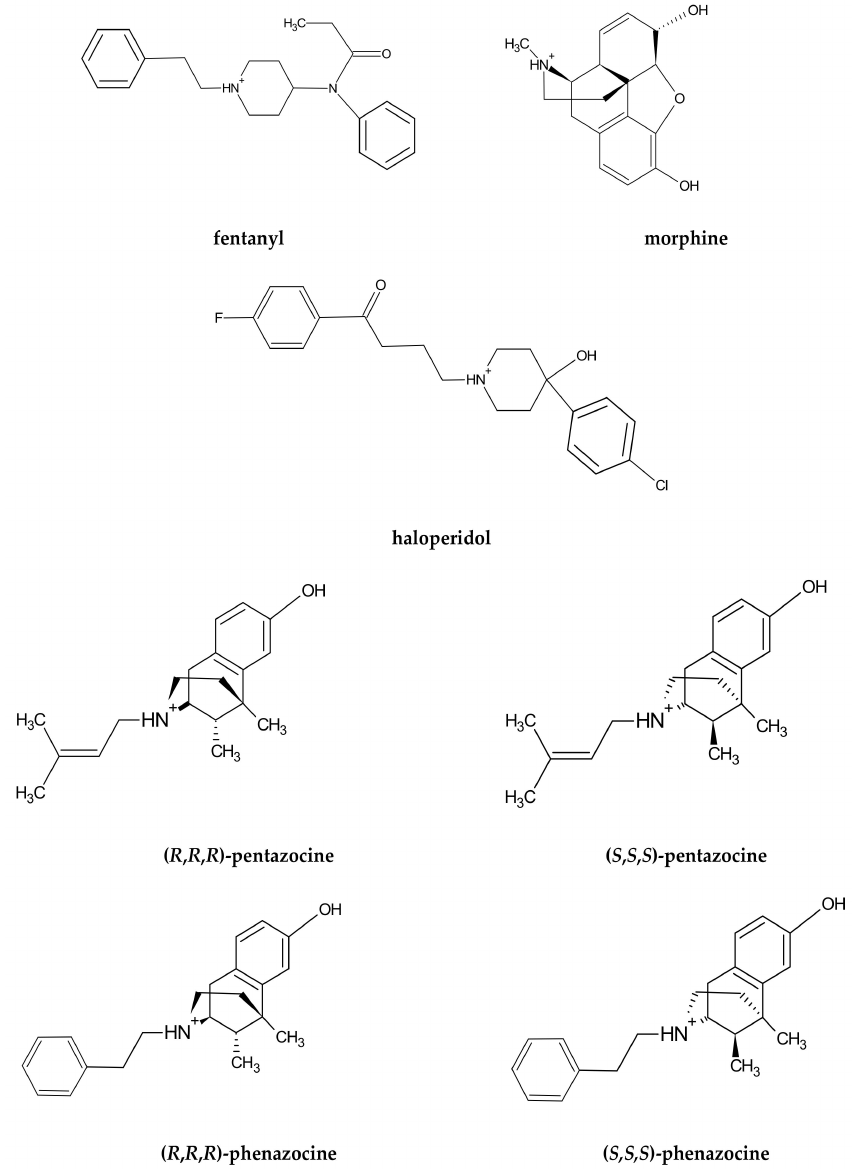
Scheme 1. Structural formulae of the studied